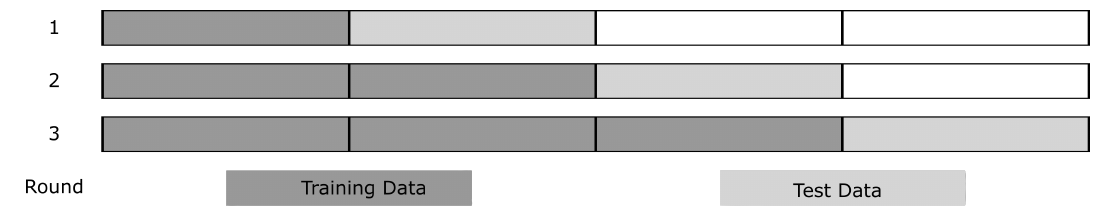
Figure 5. Example of the data split in forward-chaining cross-validation with nCV = 3 validation